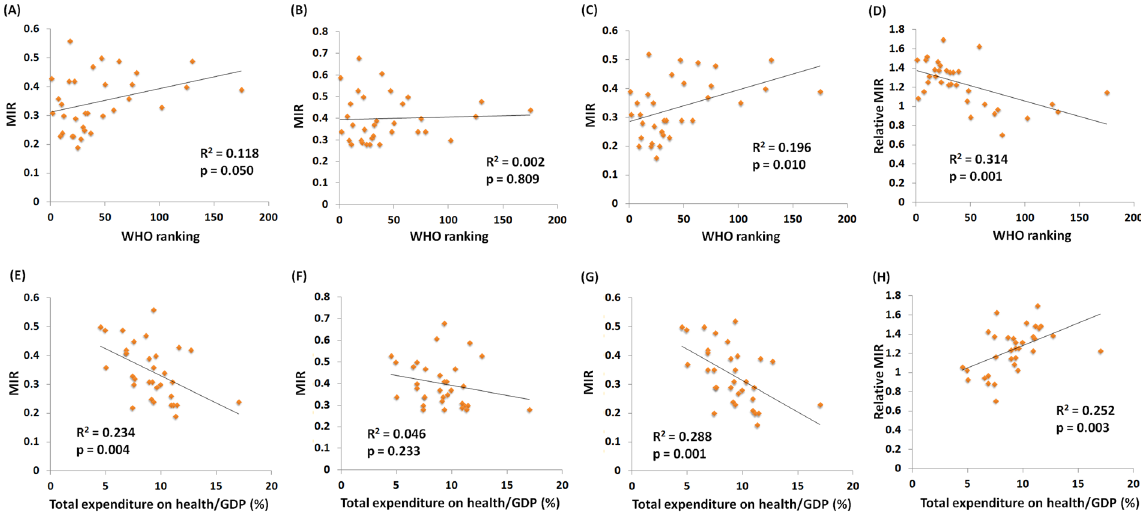
Figure 3. Countries with good world health organization ranking have low MIR in ( A ) both genders, ( B ) female, and ( C ) male, but have high relative MIR ( D ). Countries with high total expenditure on health/GDP have a relatively low MIR in ( E ) both genders, ( F ) female, and ( G ) male, but high relative MIR ( H